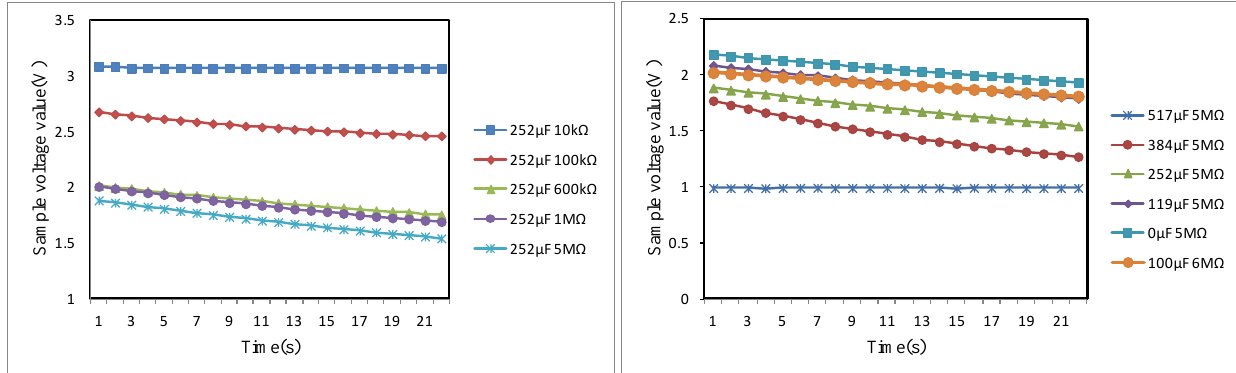
Figure 3. Sampling voltage values of different combinations of capacitance and insulation resistance under injection signal.